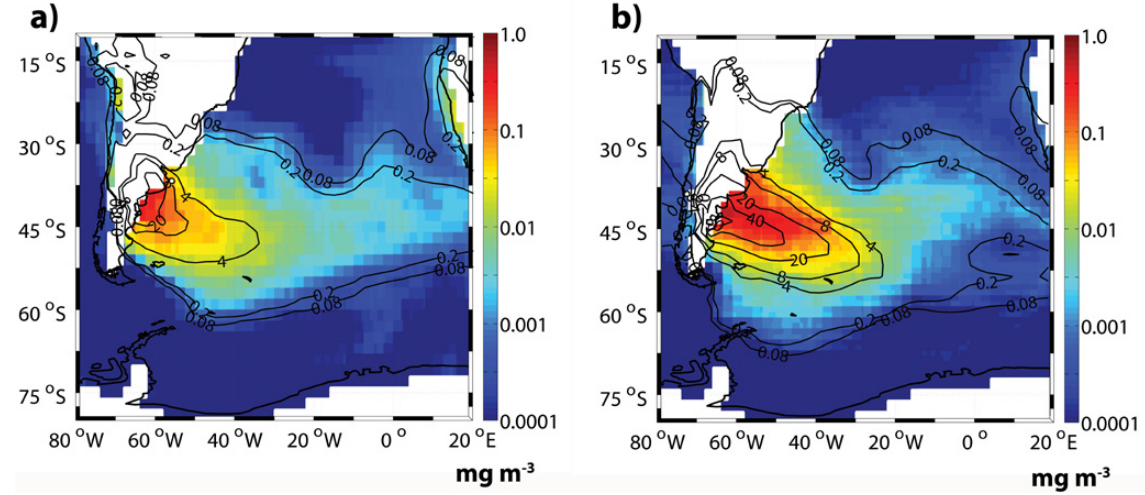
Fig. 8. GEOS-Chem/DFeS-simulated total sol-Fe fluxes (µgm − 2 ) (contour lines) and predicted [Chl- a ] increases ( 1 [Chl- a ] pred ) (mgm − 3 ) for the (a) J23 and (b) F11 dust episodes.